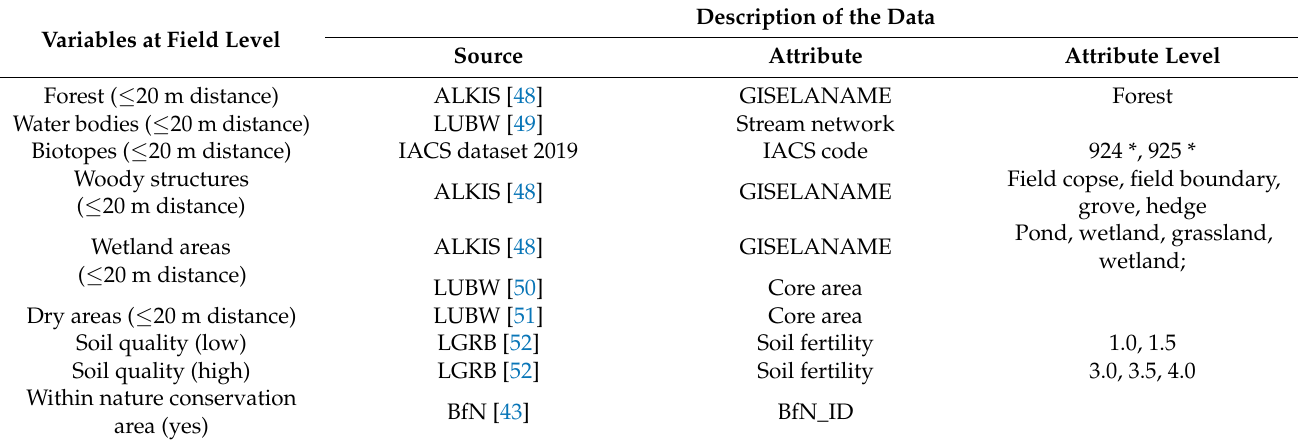
Table 4. Binary variables used to create the PIC map at field